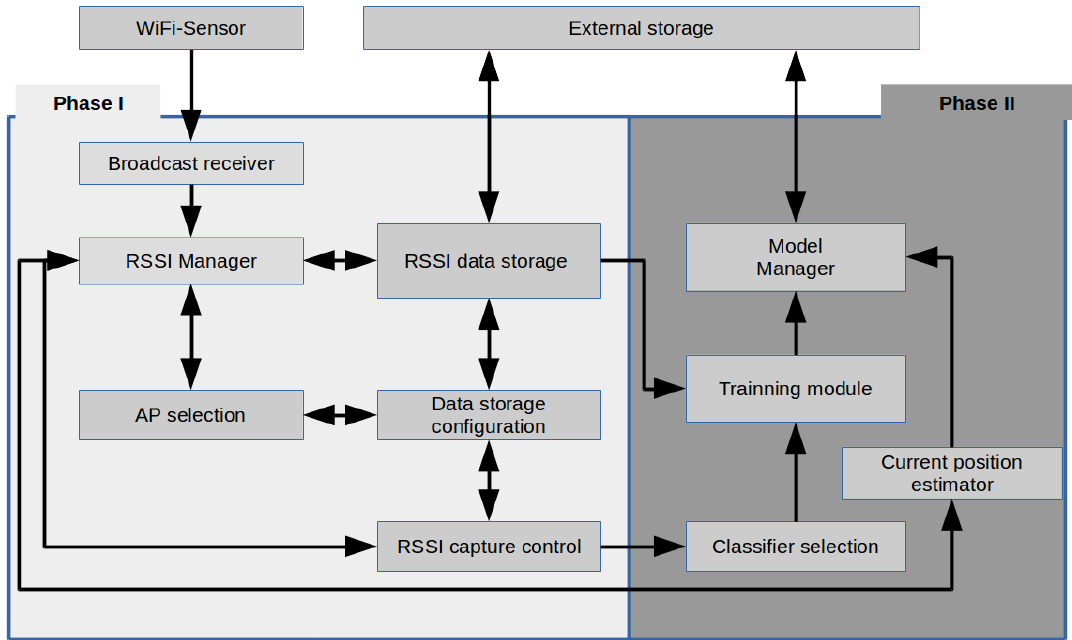
Figure 2. Block diagram of the proposed application for